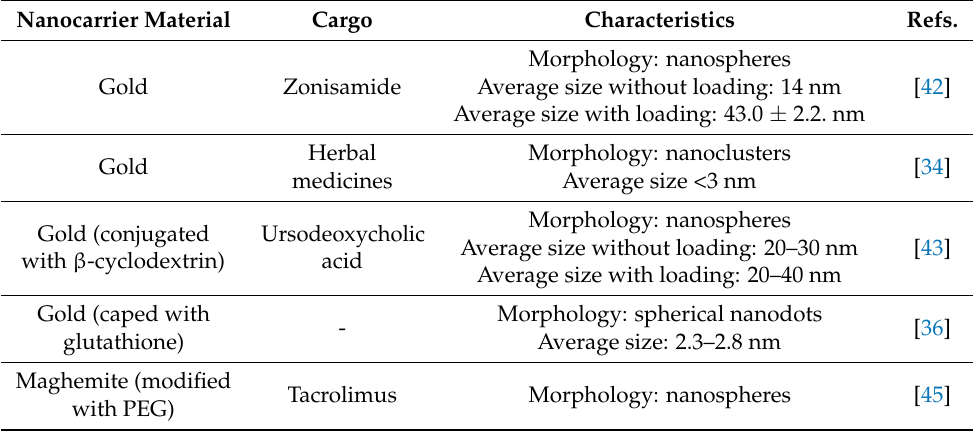
Table 2. Examples of metal-based nanosystems for spinal cord delivery. Nanocarrier